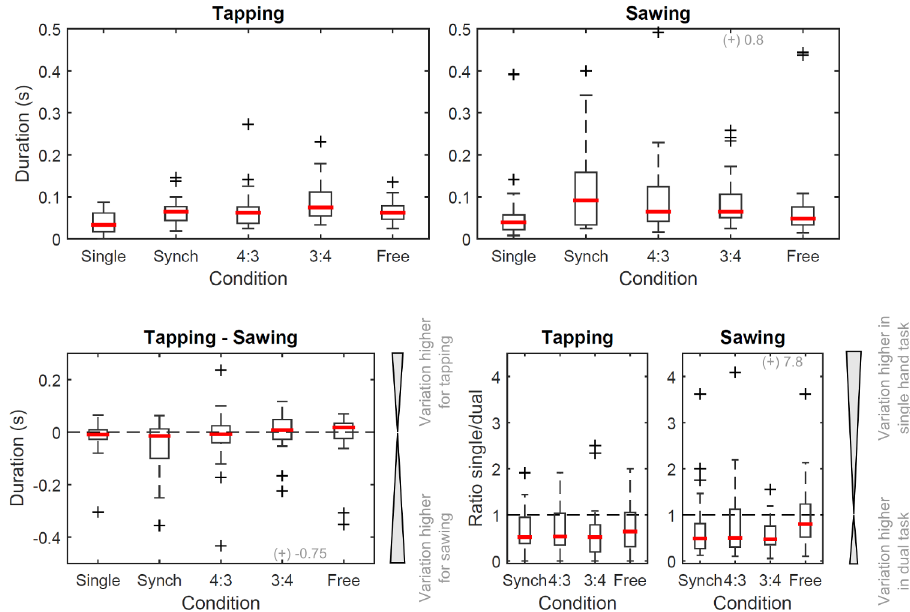
Fig 4. Boxplots showing within-participant variation as an index of stability. Top: within-participant IQR for the handperformingtapping(left) and the hand performing sawing(right), for both the single handedtask (‘single’)and the dual movement tasks (remainder). Bottom, left: participant-specific difference between within-participant variation for the hand performingtappingand the hand performingsawing.Dashedline: no difference in variation. Bottom, right: participant-specificratio of the variationobservedduringthe singlehand task comparedto the equivalent action in the four dual movement tasks. Dashedline: no difference in variation. A value of 0.5 corresponds to half the amount of variationin the singlehand task, a value of 2 corresponds to twice the variation. For further detailson experimental conditionsand legend,please refer to Fig 2.